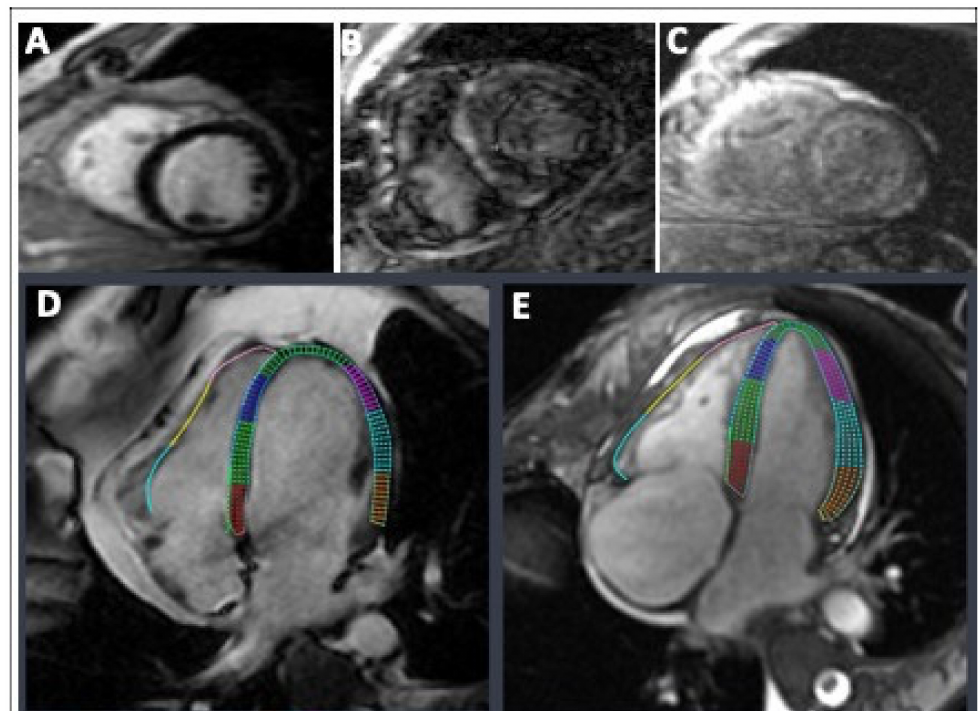
Figure 3. Cardiac MRI (CMR) visualization of cardiac amyloidosis using late gadolinium enhancement (LGE) and strain imaging. ( A – C ) Lack of myocardial nulling and characteristic speckled appearance are noted after gadolinium injection in cardiac amyloidosis. ( A ) Representative LGE-CMR short-axis image of a normal patient. ( B ) Representative LGE-CMR short-axis image of an ATTR amyloidosis patient. ( C ) Representative LGE-CMR short-axis image of an AL amyloidosis patient. ( D , E ) Visualization of left and right ventricular longitudinal strains under 4 chamber (4CH) long-axis view.